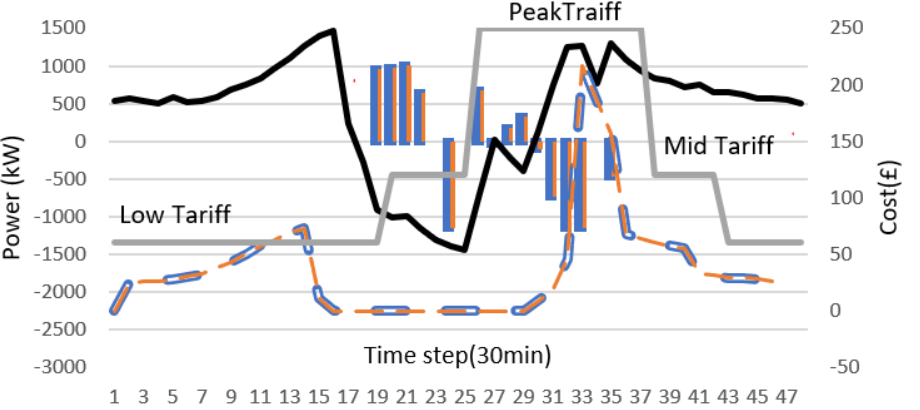
Figure 11. Comparison of offline vs. online RL after convergence.